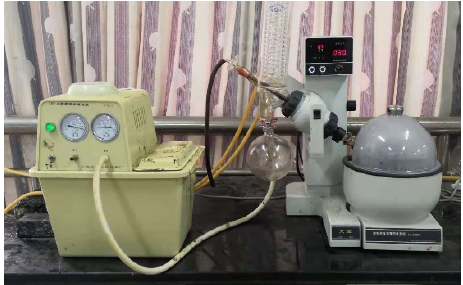
Figure 6. Rotary evaporation asphalt recovery instrument.